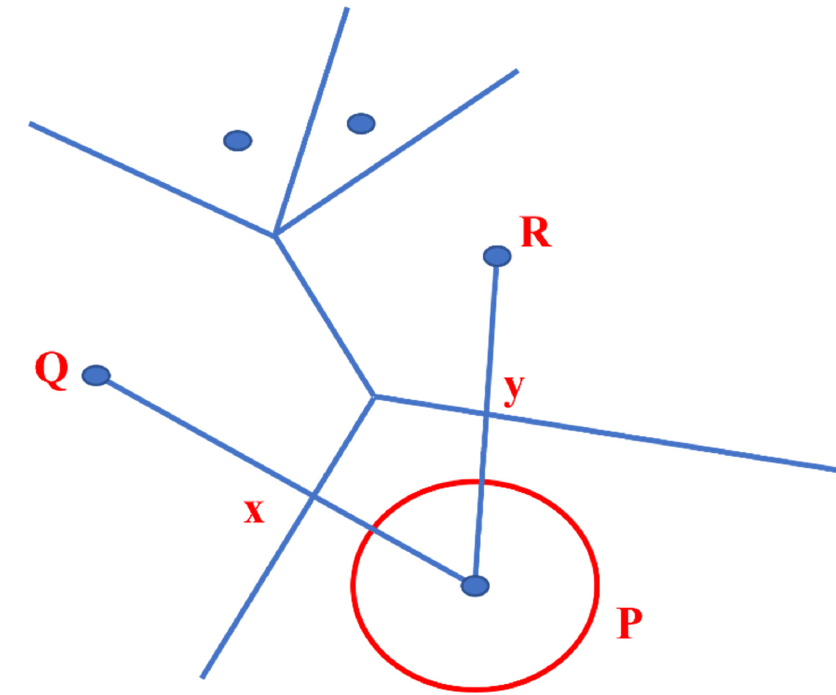
Figure 18. A simplified mobility